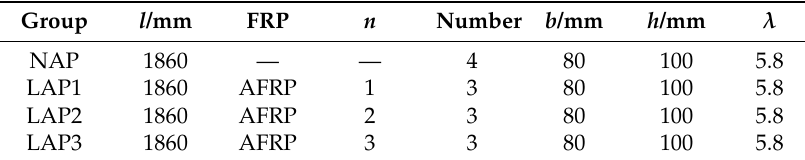
Table 1. Main parameters of specimen.